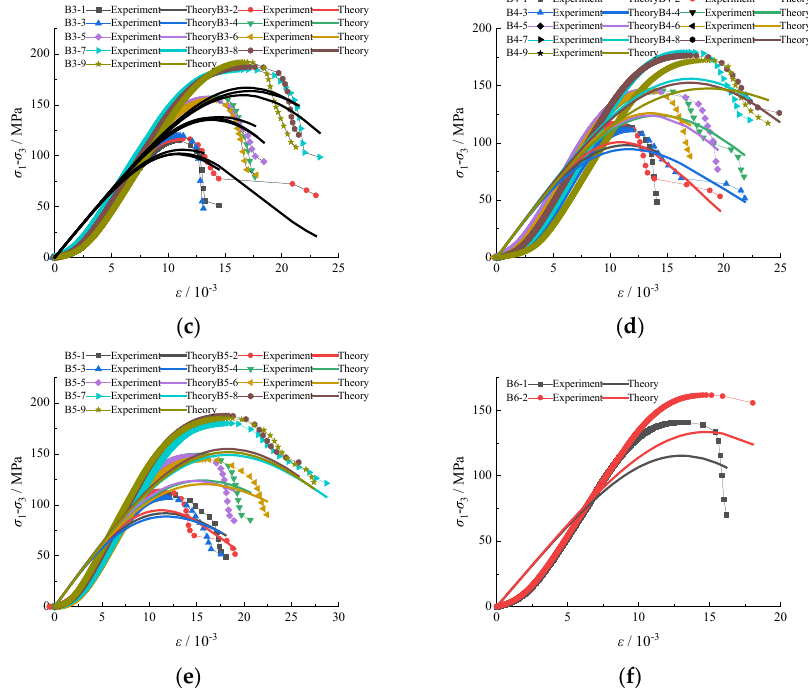
Figure 10. The stress-strain experimental curves and theoretical damage curves of sandrock con- taining water under triaxial compression status. ( a ) Dry Sample; ( b ) Sample Submerged for 0.75 h; ( c ) Sample Submerged for 1.5 h; ( d ) Sample Submerged for 6 h; ( e ) Sample Submerged for 24 h; ( f ) Sample Submerged for 720 h.